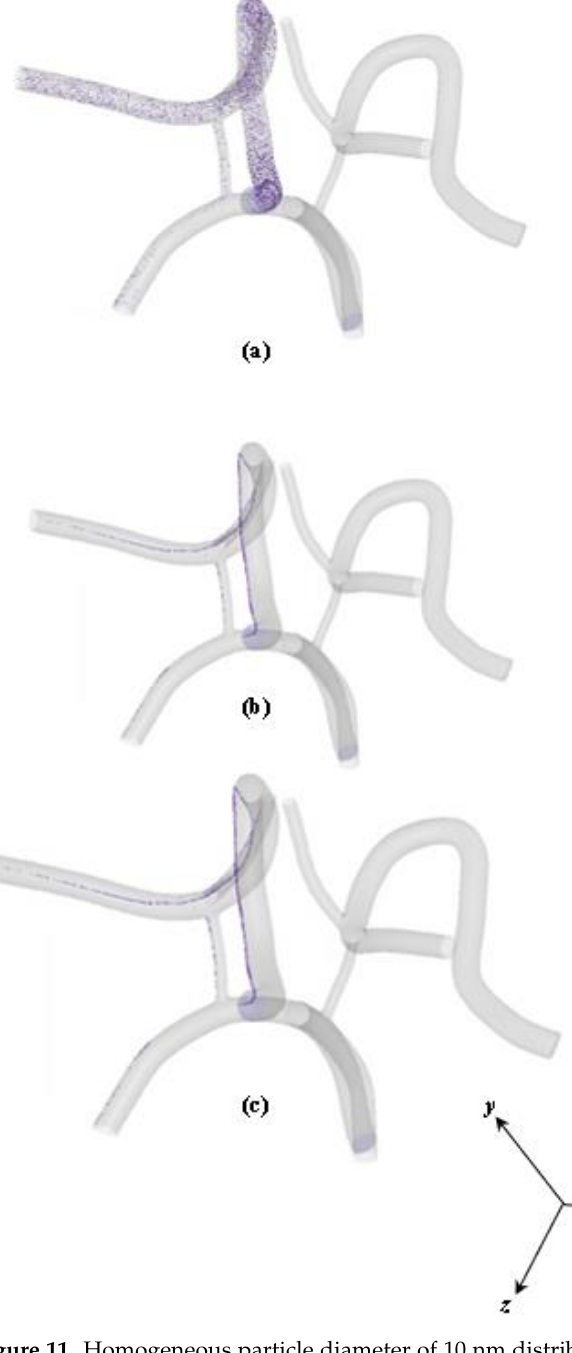
Figure 11. Homogeneous particle diameter of 10 nm distribution at different views: ( a ) isometric view, ( b ) side view, and ( c ) bottom view.